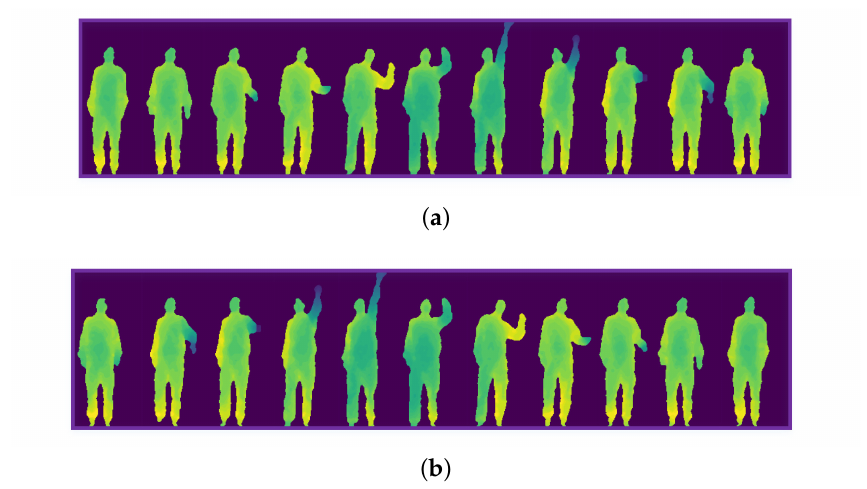
Figure 7. High throw. ( a ) The positive order of high throw; ( b ) The reverse order of high throw. Figure 8a,b are the MSTM of positive order and reverse order high throw respectively. From left to right are the MSTM of height axis, width axis and depth axis respectively. Owing to MSTM reflects the change of the energy information on the three orthogonal axes, it preserves the spatial and temporal information completely. Positive order and reverse order actions have the same motion trajectories and opposite temporal orders, the final MSTM is symmetric along the time axis and easy to be distinguish.